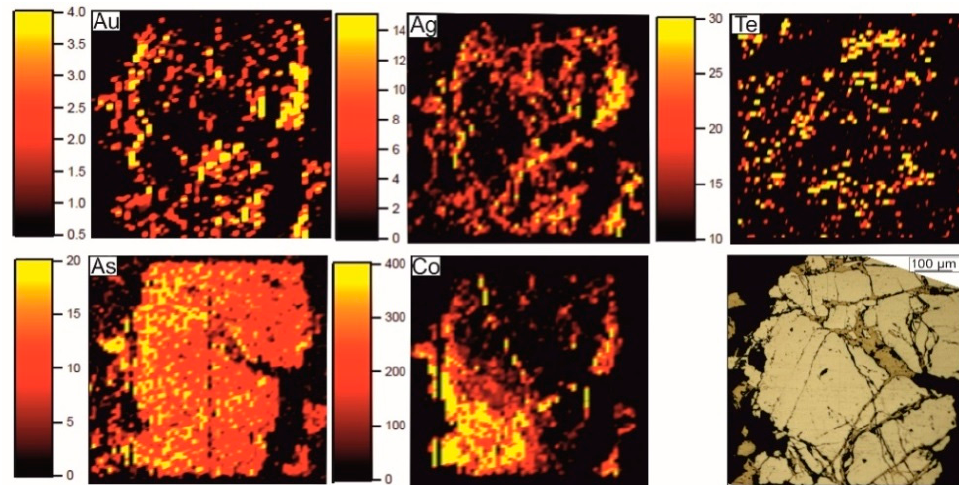
Figure 20. Binary diagrams of the contents of Au, Ag, Te and As (ppm) in pyrite of the